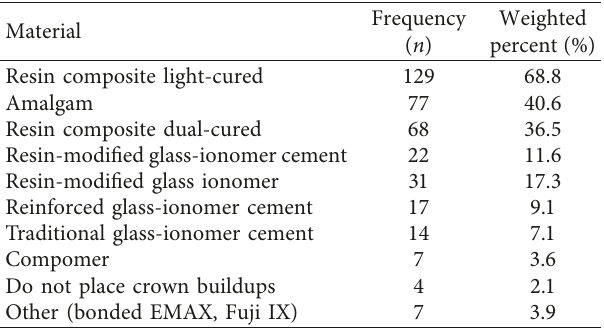
Table 1: Materials used for core buildup of vital teeth among New Zealand dentists